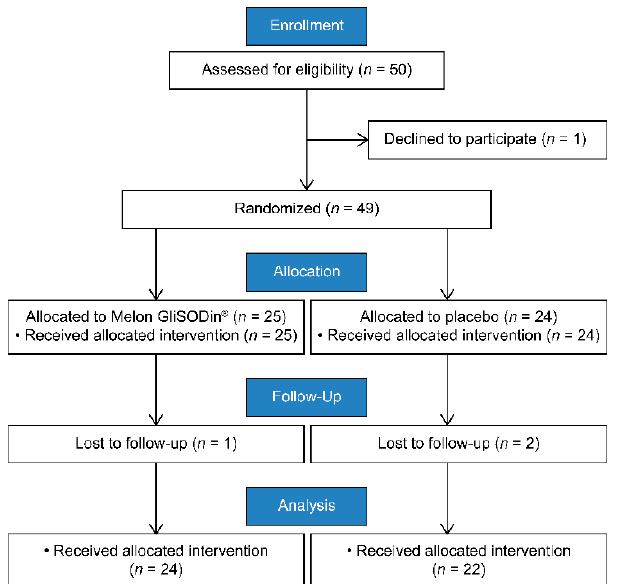
Figure 1. Flowchart outlining the study design.